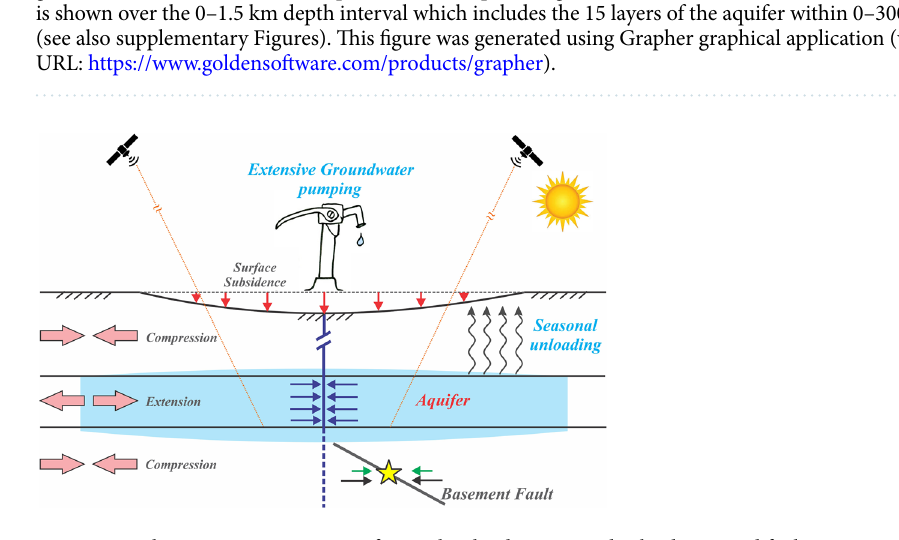
Figure 7. Schematic representation of crustal unloading, ground subsidence, and faulting associated with groundwater extraction from unconfined aquifer and seasonal unloading. The light blue color region indicates depressurized zone within the aquifer due to extensive groundwater extraction from unconfined aquifer. Compression of basement rocks near extensive pumping favors reverse faulting. Crustal unloading due to groundwater extraction and seasonal unloading cause basement expansion which can apply horizontal compression (green arrows) on bounding faults that are far from the aquifer. This compression adds to the secular long-term contraction (black arrows). Yellow star represents hypothetical hypocenter of seismicity at the basement faults. This figure was generated using Corel Draw graphical application (version 18 URL: https:// www. corel draw. com/